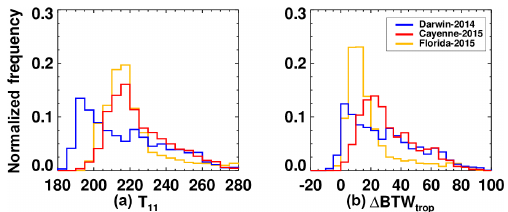
Figure 3. Distributions of BTW (a) and (cid:49) BTW (b) differentiated by HIWC and HAIC flight campaign using the colors shown in the